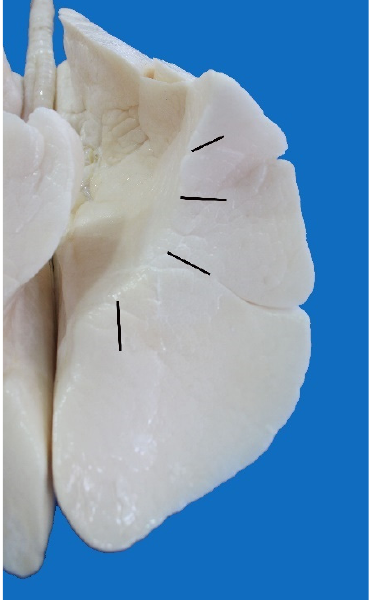
Figure 14. Detail of the cardiac impression in the left